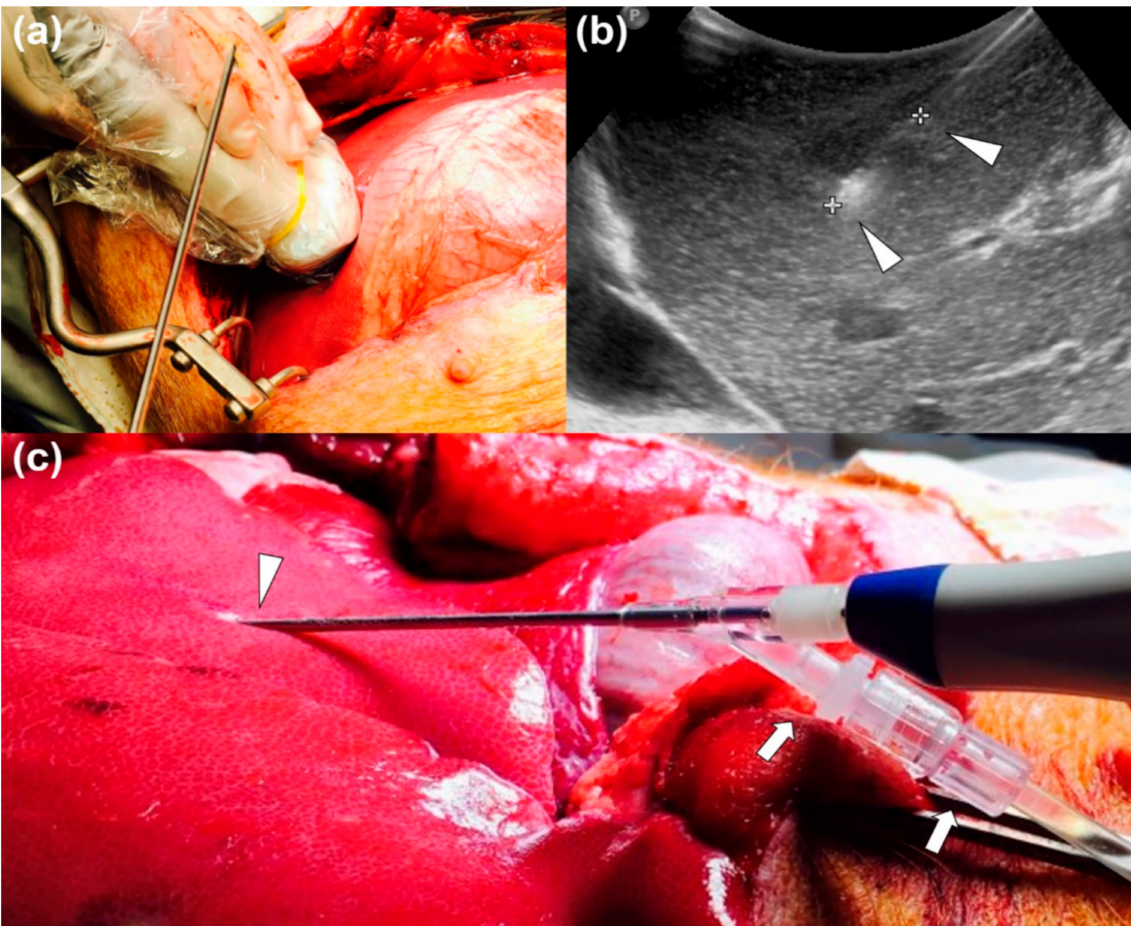
Figure 3. Radiofrequency ablation (RFA) procedural details. ( a ) Intraoperative view during the drug-releasing RFA in a pig under sonographic guidance. ( b ) The drug-releasing cooled wet electrode was inserted into the liver parenchyma. ( c ) 18 F-fluorodeoxyglucose was simultaneously slowly injected (arrow) during the RFA